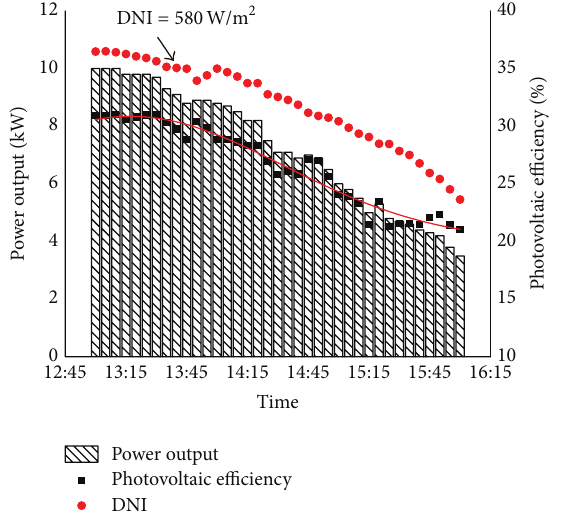
Figure 10: Photovoltaic performance of the HCPV/T array.